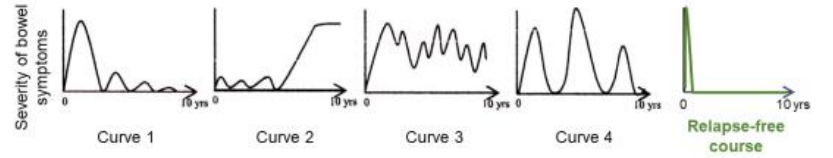
Figure 15. Graphic of clinical course in Crohn’s disease. Solberg et al. [60] presented four graphic clinical courses of CD: curve 1 (decrease in the severity of bowel symptoms), curve 2 (increase in the severity of bowel symptoms), curve 3 (chronic continuous bowel symptoms), and curve 4 (chronic relapsing bowel symptoms) (with permission from Elsevier). A relapse-free course was achieved in nearly half of the CD patients with infliximab and a plant-based diet as first-line (IPF) therapy (with permission from the Permanente Federation).